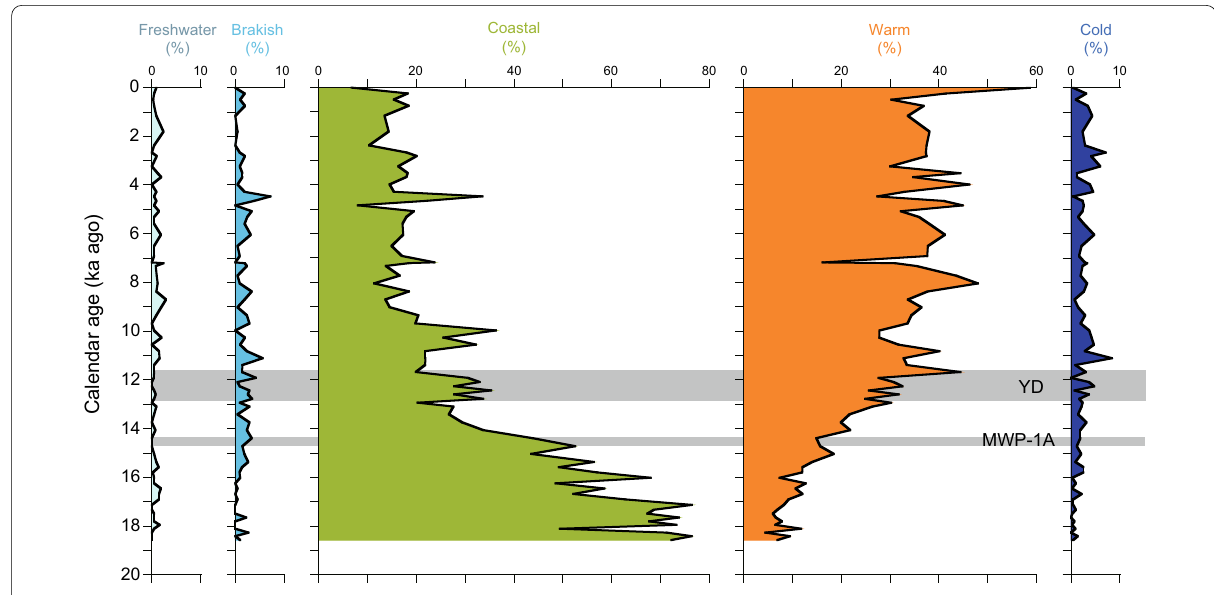
Fig. 4 Downcore profiles of diatom environmental indicators: relative abundances (%) of freshwater (light blue); brackish (cyan); coastal (green); warm (orange); and cold (blue) in Core KY07-04 PC01 (Table 2). Gray hatches indicate MWP-A and YD